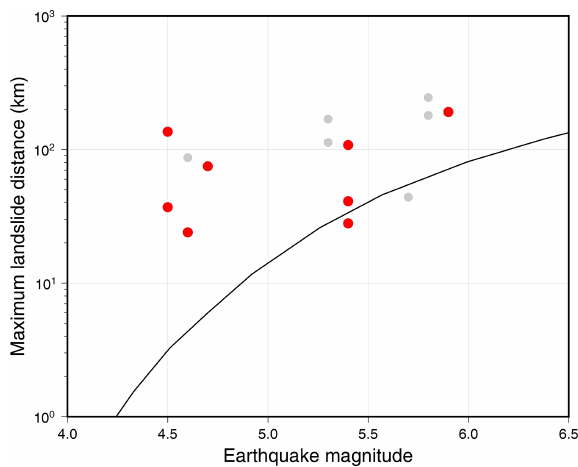
Figure 7. Landslide distance limits for earthquakes in intraplate ar- eas. Red dots: Norway (this study), grey dots: other areas (1988 Saguenay, Canada (Lefebvre et al., 1992); 1988–1994 Colorado Plateau, USA (Keefer, 2002); 2011 Virginia, USA (Jibson and Harp, 2012)) and black curve: maximum landslide distance limit for dis- rupted slides and falls from Keefer (1984).